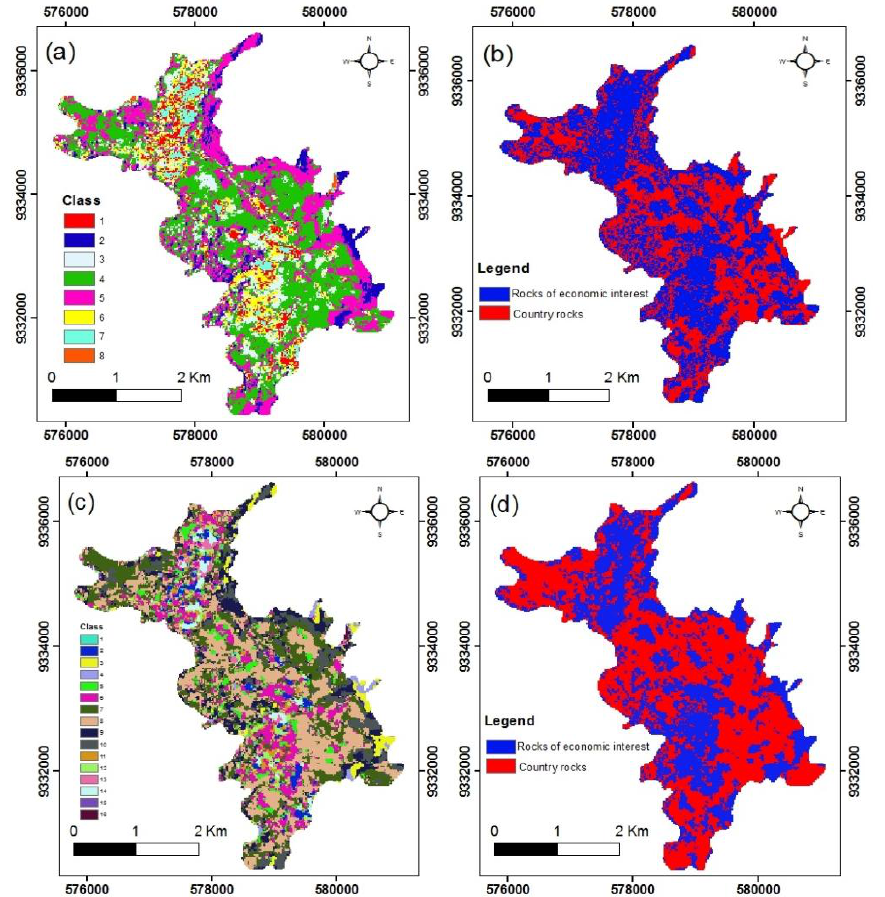
Figure 10. Classifications of the R99B images using hybrid methods: ( a ) image classified by the Wishart-H- method; ( b ) composite image of the classification by the Wishart-H- method; ( c ) image classified by the Wishart-H- -A method; ( d ) composite image of the classification by the Wishart-H- -A method.